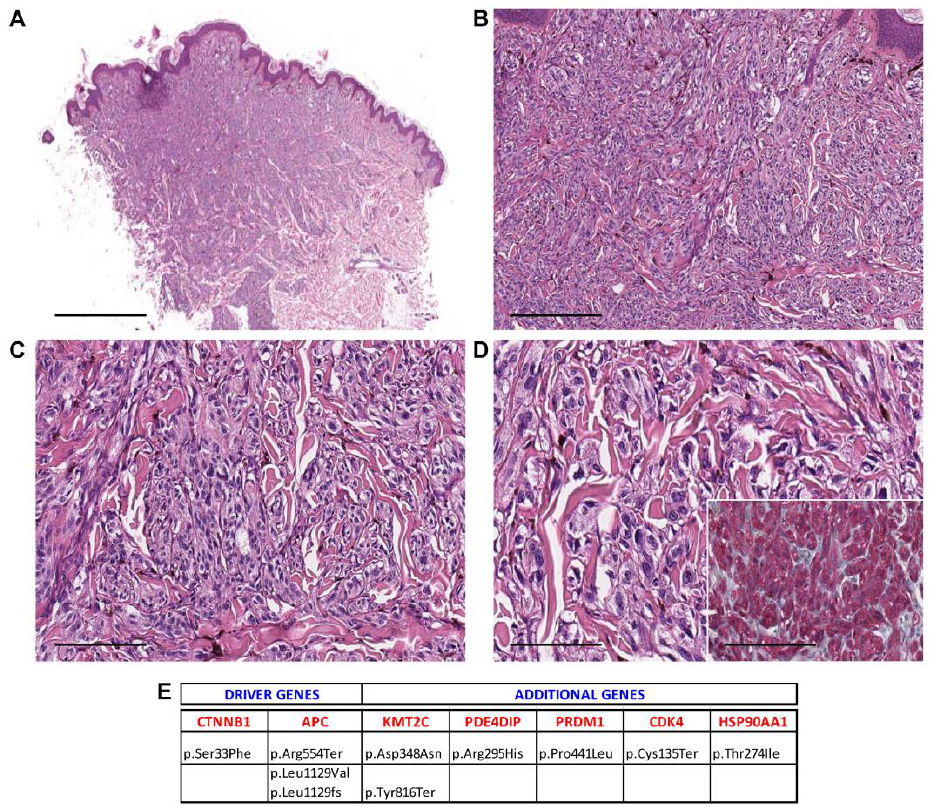
Figure 1. Case 2—male, 12 years old, shoulder. ( A ) Melanocytic tumor with an inverted triangle-like downward architecture in the dermis and subcutis. (40 × , scale bar 500 µ m); ( B ) short fascicles of spindled, ovoid, and occasionally epithelioid melanocytes (100 × , scale bar 100 µ m); ( C ) melanocytes intermingled with scattered melanophages (200 × , scale bar 50 µ m); ( D ) some melanocytes showing enlarged and hyperchromatic nuclei (400 × , scale bar 25 µ m). Inset: β -catenin staining shows nuclear positivity (400 × , scale bar 25 µ m). ( E ) Mutational profile: driver gene mutations and additional pathogenic alterations.